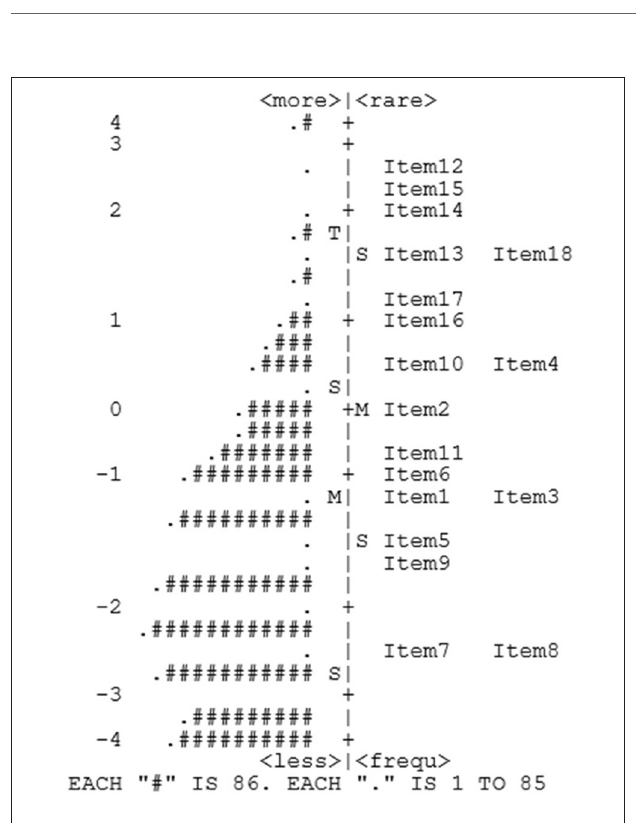
FIGURE 1 | Variable